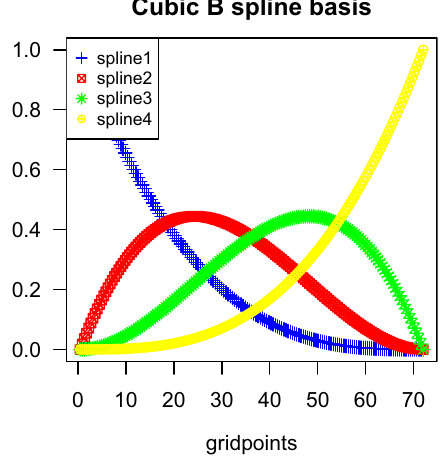
Figure 5. The 4 cubic B-splines.